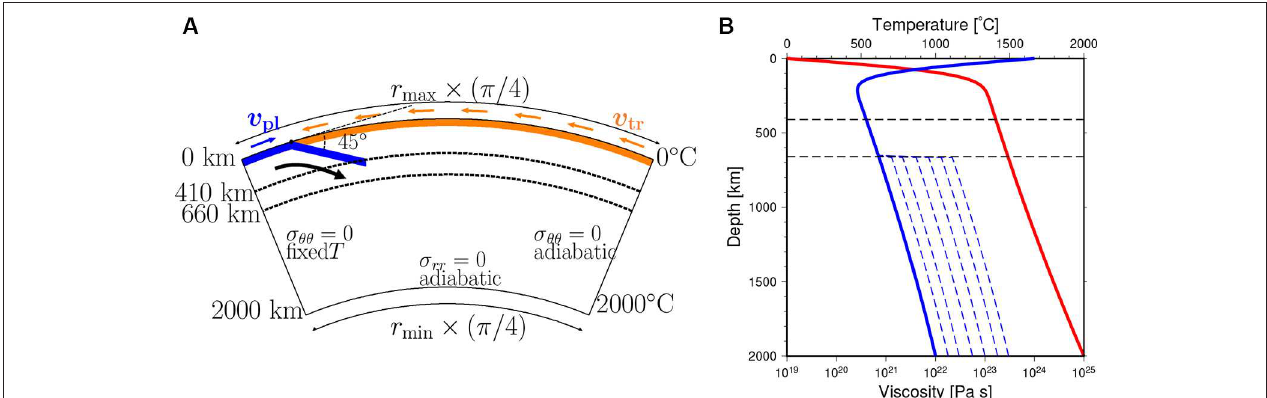
FIGURE 1 | (A) A schematic figure of our 2-D numerical model in a spherical annulus. The blue segment indicates the channel of cold fluid as a model of subducting plate. The maximum depth of its upper plane is 400 km. The orange segment shows the overriding plate. The dashed lines are the phase boundaries around 410 and 660 km. (B) The initial depth distribution of temperature T (red line) and viscosity η (blue lines). The horizontal axes show the viscosity (bottom) and the temperature (top), and the vertical axis shows the depth. The blue solid line indicates the viscosity calculated by Equation (1) with r η r η 1.8, 3, 5.6, 10, 18, and 30, =